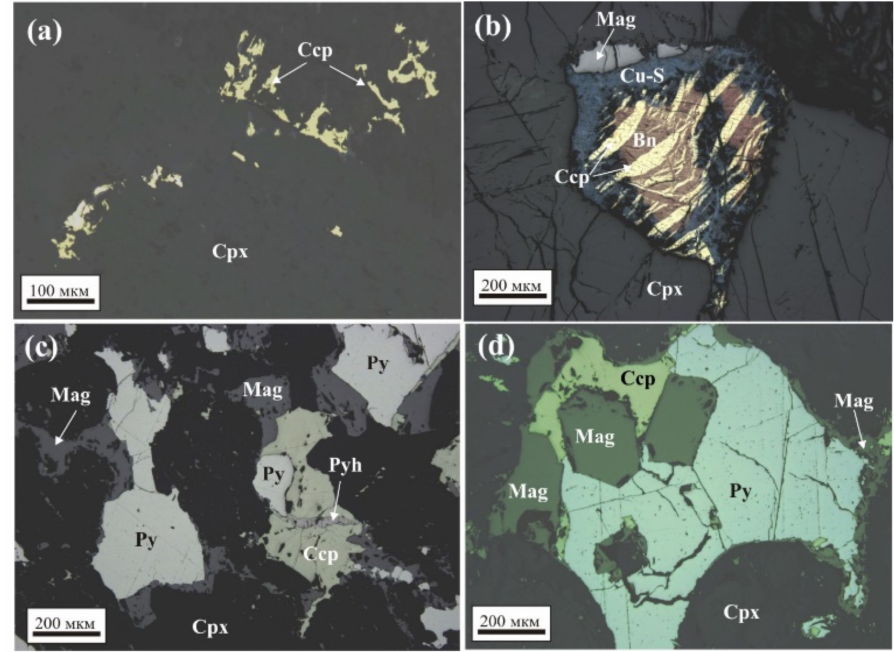
Figure 2. Relationships of main ore minerals in the samples of clinopyroxenites I ( a ), II ( b ),